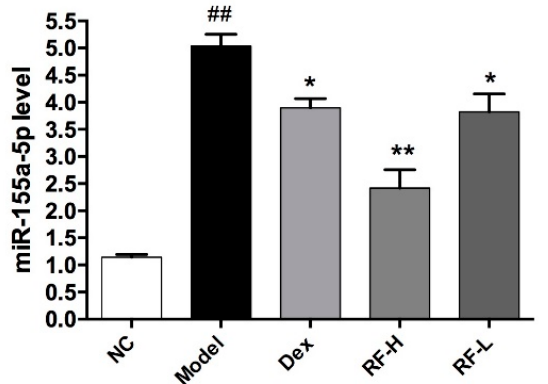
Figure 8. The effects of Renifolin F on the expression of microRNA 155 in the lung. Normal control, saline-induced mice only. Model, OVA-induced mice. Dex, OVA-induced mice treated with Dex (1.0 mg/kg). RF-H, OVA-induced mice treated with Renifolin F (3.0 mg/kg). RF-L, OVA-induced mice treated with Renifolin F (1.5 mg/kg). Statistics represented as the mean ± SEM ( n = 6). ## p < 0.01 vs. Normal control, * p < 0.05 vs. Model and ** p < 0.01 vs. Model.